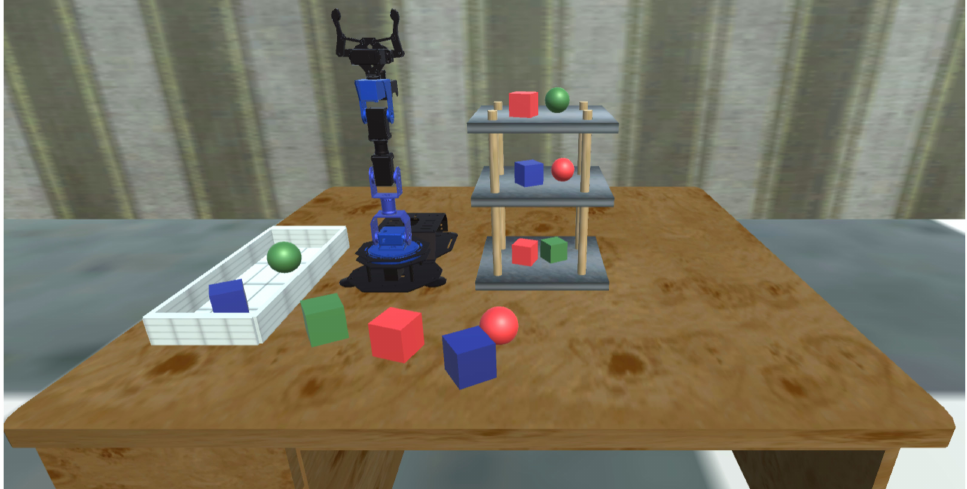
Figure 7. 3D scene of virtual